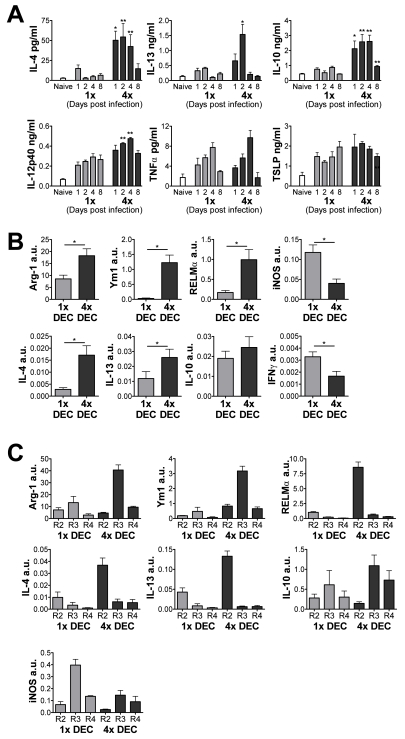
Multiple infections induce a Th2-type cytokine environment in the skin and
induce the expression of markers of alternative activation.(A) Cytokine production by skin biopsies from 1x and 4x mice taken at different
days post-infection. Bars show mean cytokine + SEM
(n = 6). (B) Analysis of mRNA transcript levels from 1x
and 4x DEC collected on day 4 post-final infection defined by qRT-PCR. Data are
shown in arbitrary units (a.u.) + SEM relative to the expression of GAPDH
for each sample (n = 5). (C) Transcript levels of DEC
sorted into regions R2-R4 on the basis of F4/80 and MHC-II. Data are means
+ SEM of 3–4 separate experiments using DEC populations
(n = 15 mice). Significances are shown between groups
indicated by connector bars, of naïve or 4x mice compared to 1x mice.